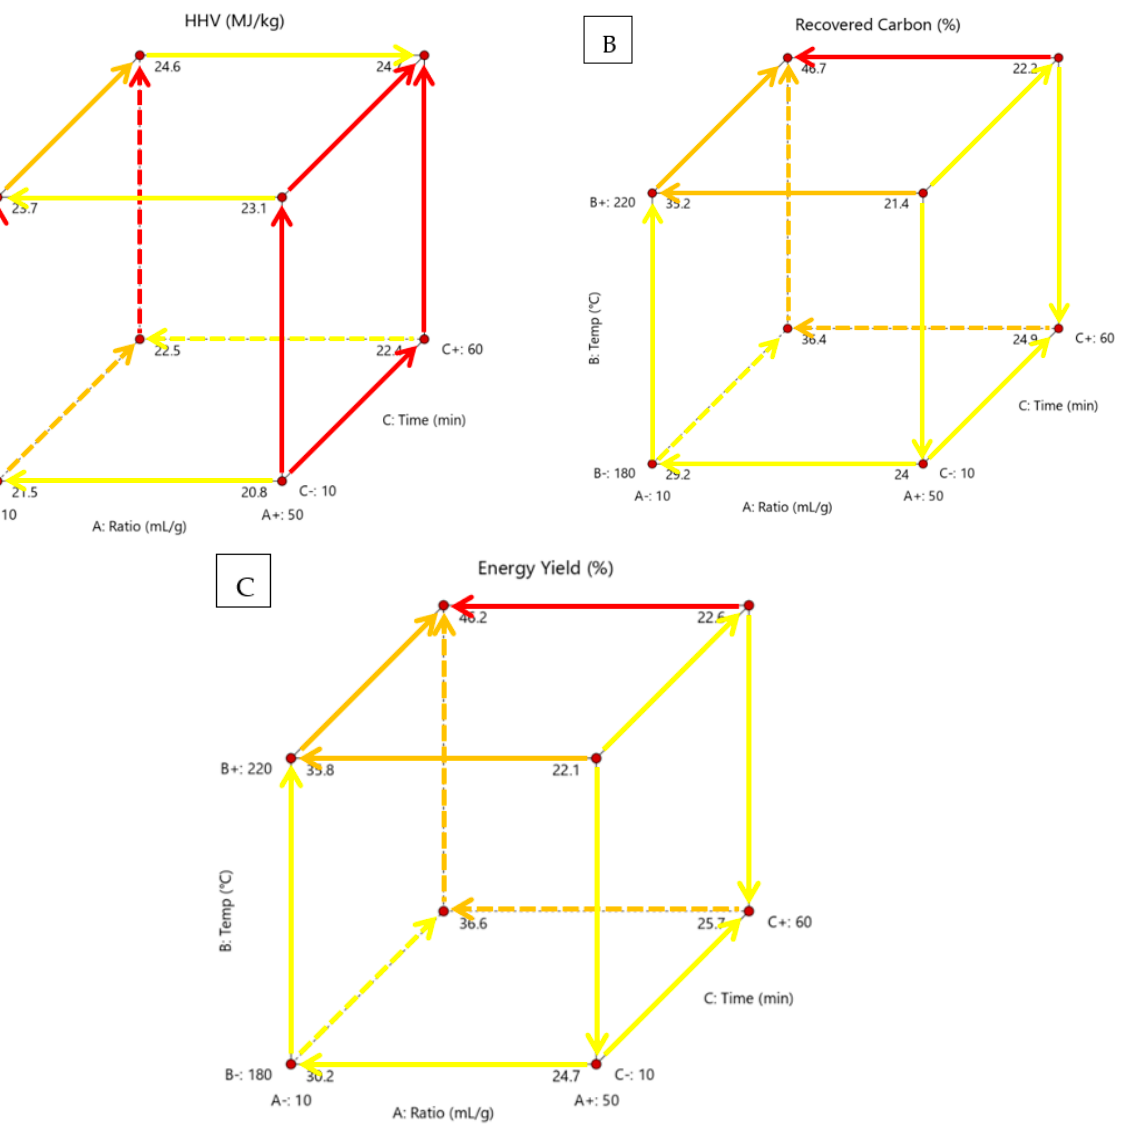
Figure 5. Cubic display of the effect of process temperature, solution ratio and residence time on ( A ) HHV, ( B ) recovered carbon, ( C ) and energy yield, with highlighted relationships and direction of development.